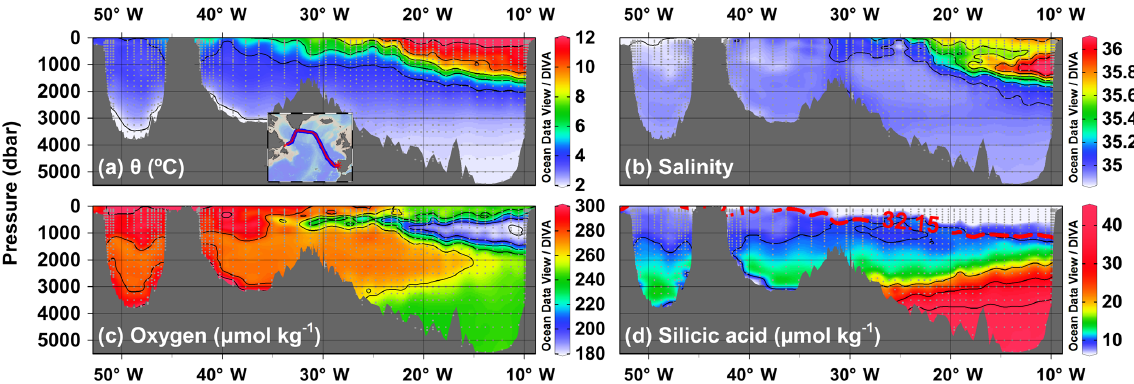
Figure 2. (a) Potential temperature ( θ , in ◦ C), (b) salinity, (c) oxygen (in µmolkg − 1 ) , and (d) silicic acid (in µmolkg − 1 ) along 2014 GEOVIDE cruise (GEOTRACES-GA01 section, inset in subplot a ), from Portugal (right) to Canada (left). Sample locations appear as grey dots. The dashed horizontal red line in subplot (d) represents the isopycnal σ 1 = 32.15kgm − 3 (where σ 1 is potential density referenced to 1000dbar), which marks the limit between the upper and lower limbs of the Atlantic Meridional Overturning Circulation (AMOC) at the GEOTRACES-GA01 section (Zunino et al.,